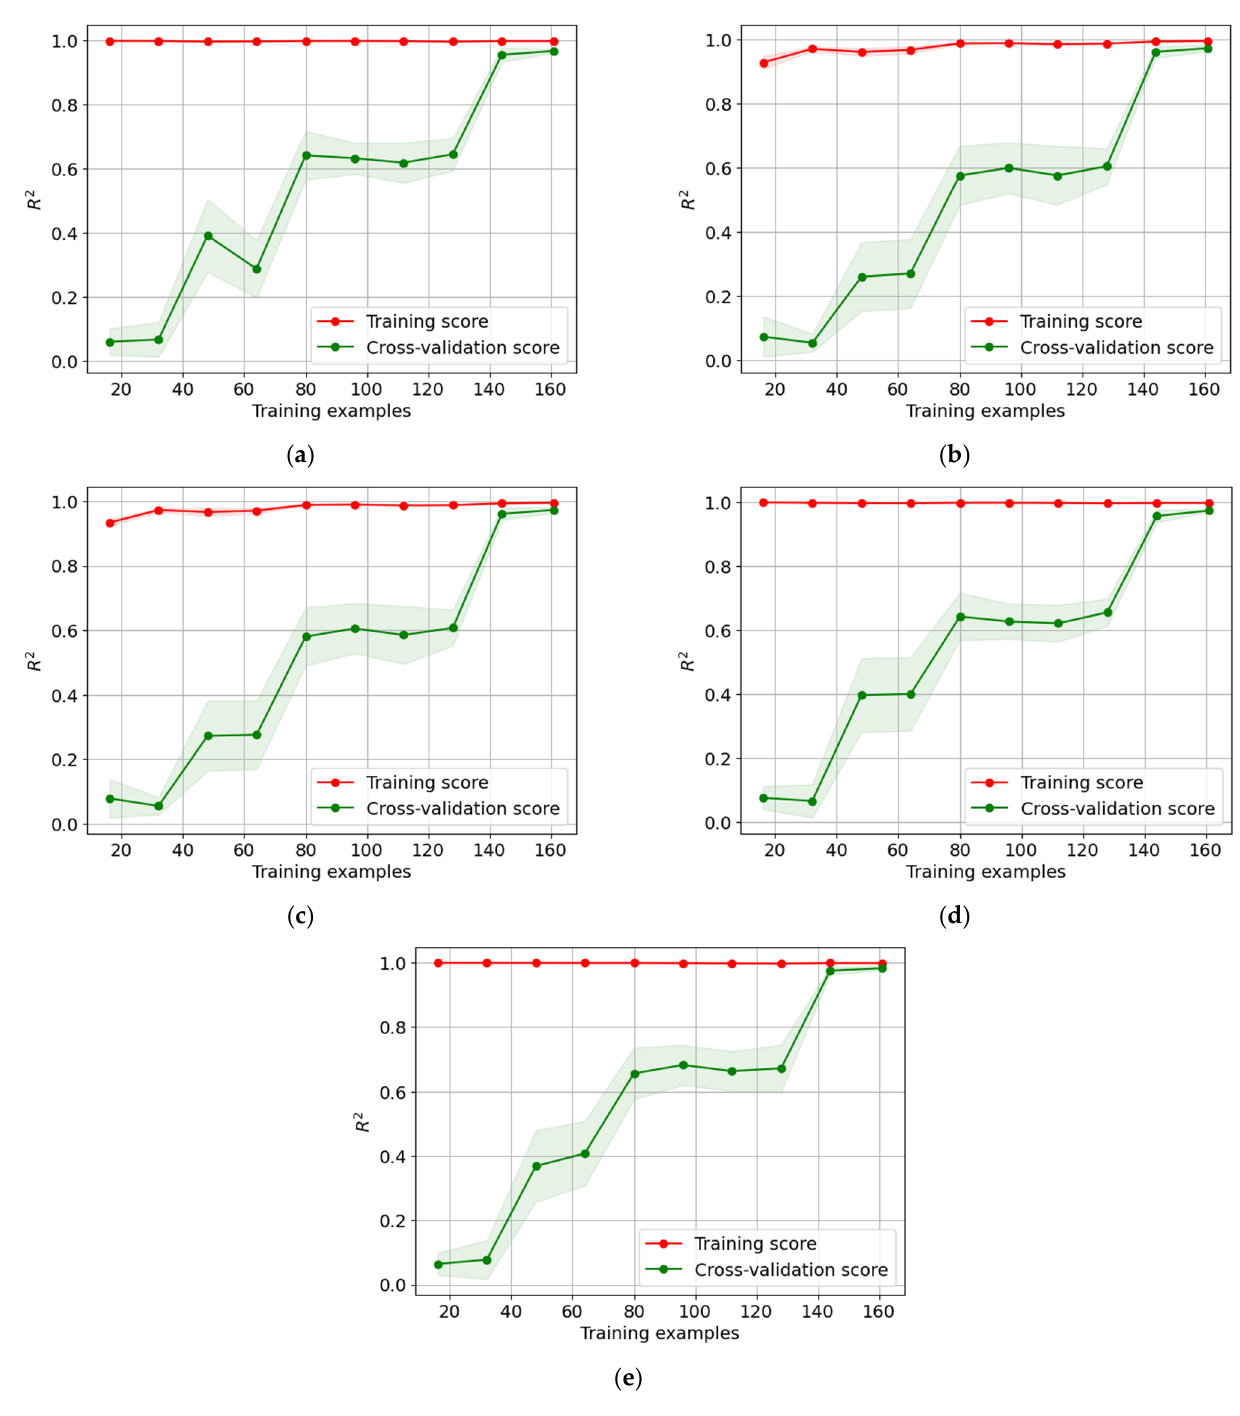
Figure 8. Learning curves: ( a ) DT, ( b ) BME, ( c ) FRT, ( d ) AB and ( e ) GTB.